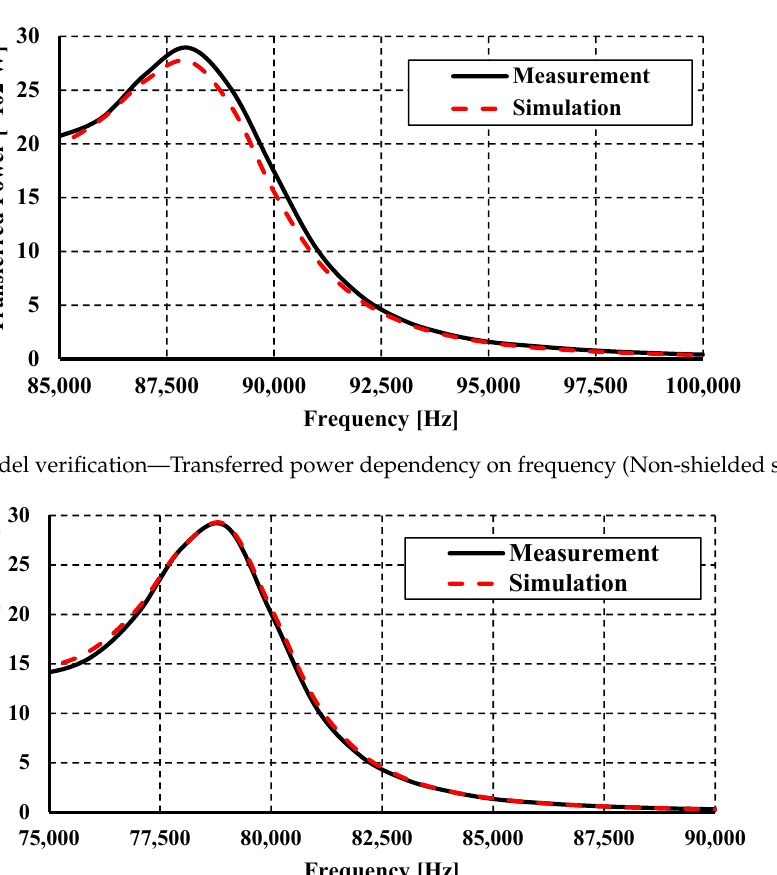
Figure 8. Model verification—Transferred power dependency on frequency (System with magnetic shielding).